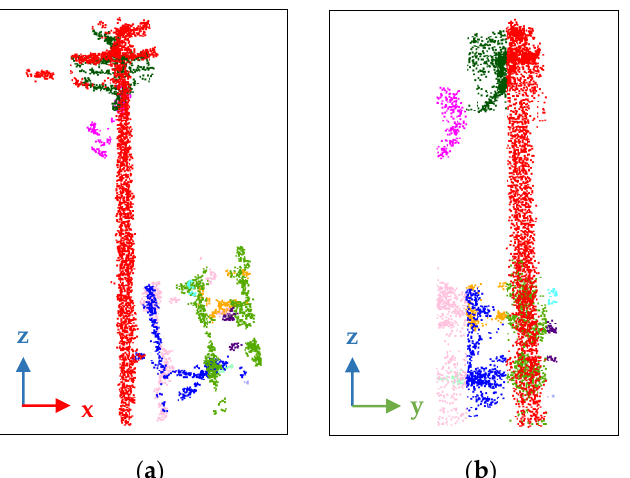
Figure 8. Schematic diagram of DBSCAN clustering: ( a ) Projection to the XZ plane. ( b ) Projection to the YZ plane.